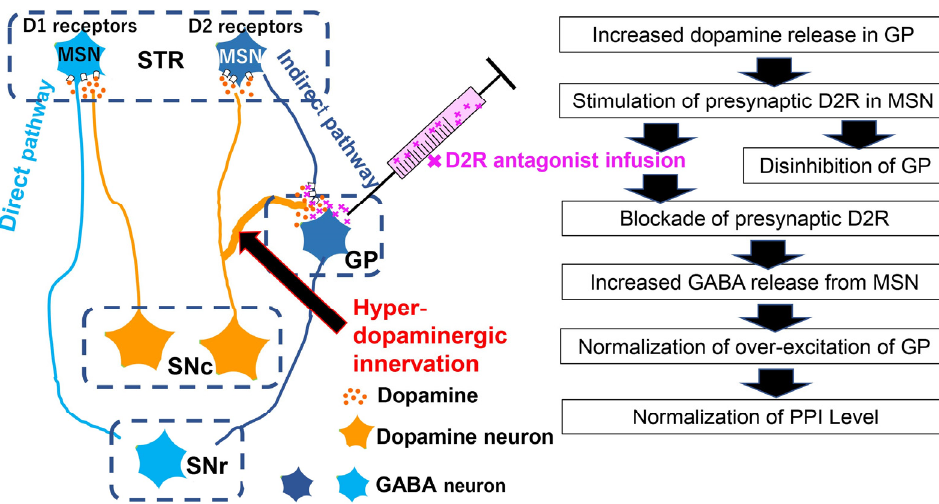
Figure 4. Abnormal basal ganglia circuits of the EGF model. In the EGF model, the globus pallidus receives hyper-dopamine innervation of the A9 pathway. Blockade of dopamine D2 receptors in the globus pallidus normalizes the local dopamine transmission and elevates GABA release from the terminals of medium spiny neurons (MSN). The following enhanced inhibition of GP neurons ame- liorates the deficit in prepulse inhibition (PPI) [83]. STR: striatum; GP: globus pallidus; SNc: substantia nigra pars compacta; SNr: substantia nigra pars reticulata. Note; the two major circuits of direct and indirect pathways are present in the basal ganglia, counteractively regulating movement, attention, sensory filtering, etc. The direct and indirect pathways stem from the two types of MSN in STR which express dopamine D1 and D2 receptors, respectively.